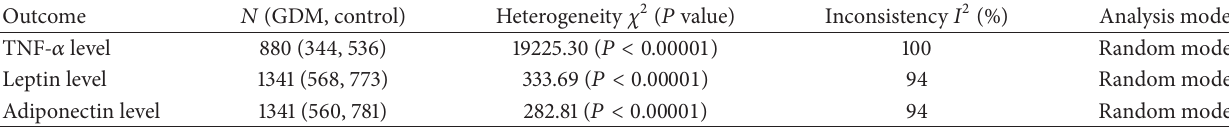
Table 3: Summary of heterogeneity of these